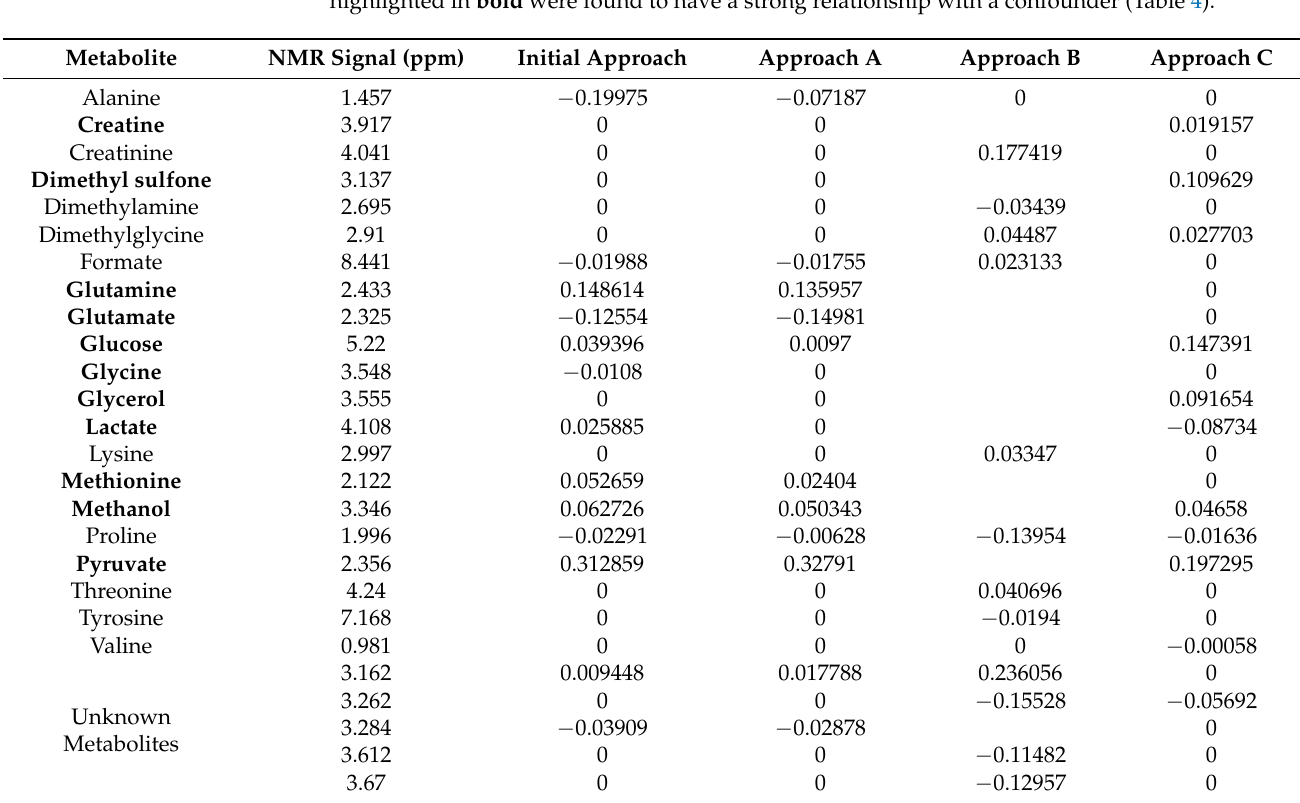
Table 3. Regression coefficients for peaks representative of each metabolite, obtained via sPLSDA on the EHT vs. PHT scenario, from each approach. Most peaks that were selected as predictors via the Initial Approach were not selected via Approach C. Lactate, which was selected by both, has a negative coefficient in the Approach C model, contrasting the Initial Approach. Metabolites highlighted in bold were found to have a strong relationship with a confounder (Table